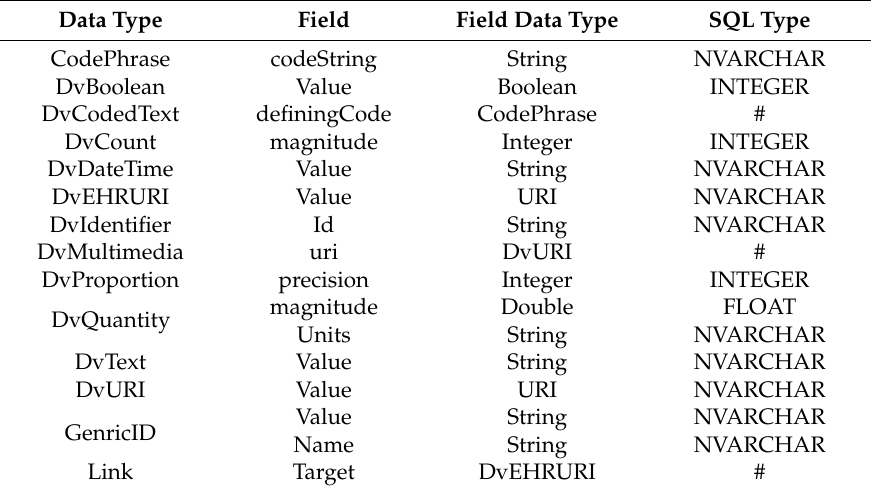
Table A1. Archetype basic data types and mapping rules